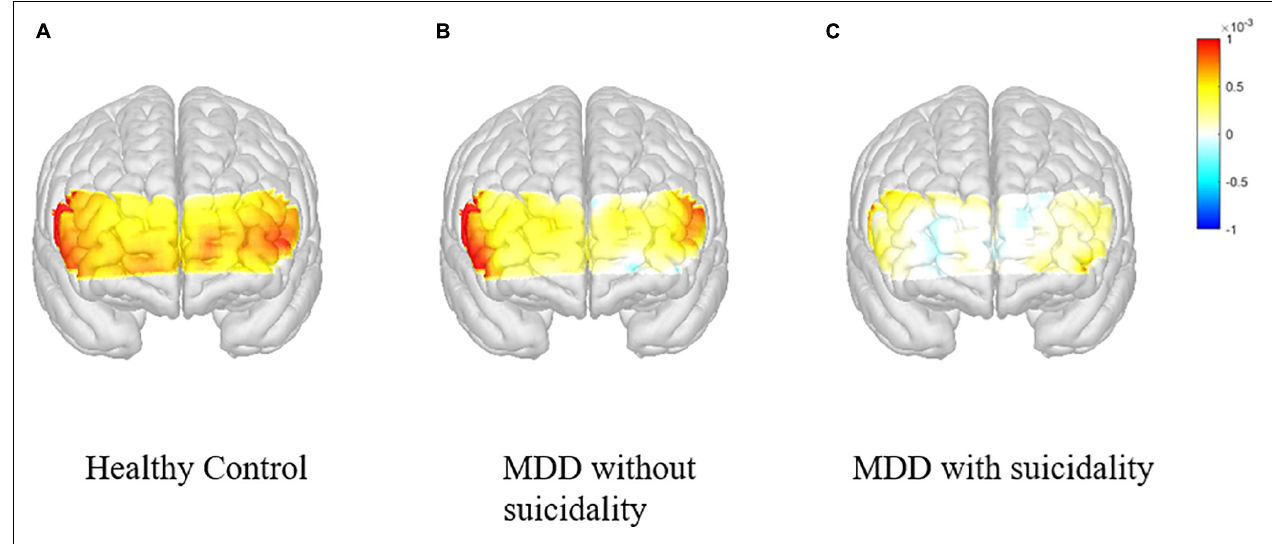
FIGURE 2 | Changes in the concentration of oxygenated hemoglobin in the prefrontal cortex during VFT according to participant groups. VFT, verbal fluency test. (A) Healthy control. (B) MDD without suicidality. (C) MDD with